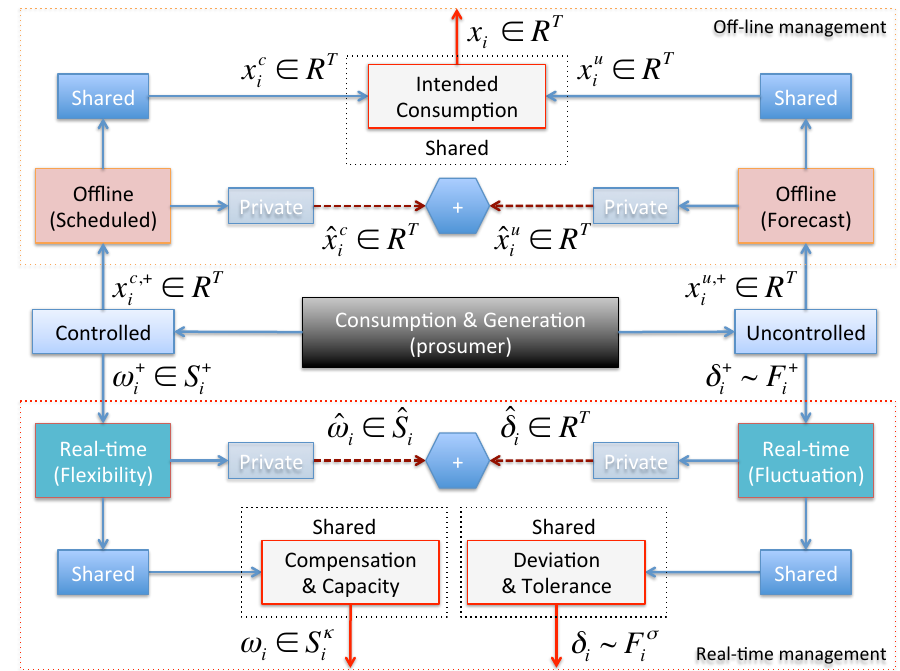
Figure 7. Augmented prosumer model. The power consumption is decomposed based on three aspects: controlled/uncontrolled, off-line/real-time, and shared/private resources, giving a total of eight components. In total, three components are shared (shown in red boxes/arrows) and can be jointly managed with the community: the intended power consumption x i , the deviation δ i ∼ F σ and the compensation ω i ∈ S κ . See main text for i